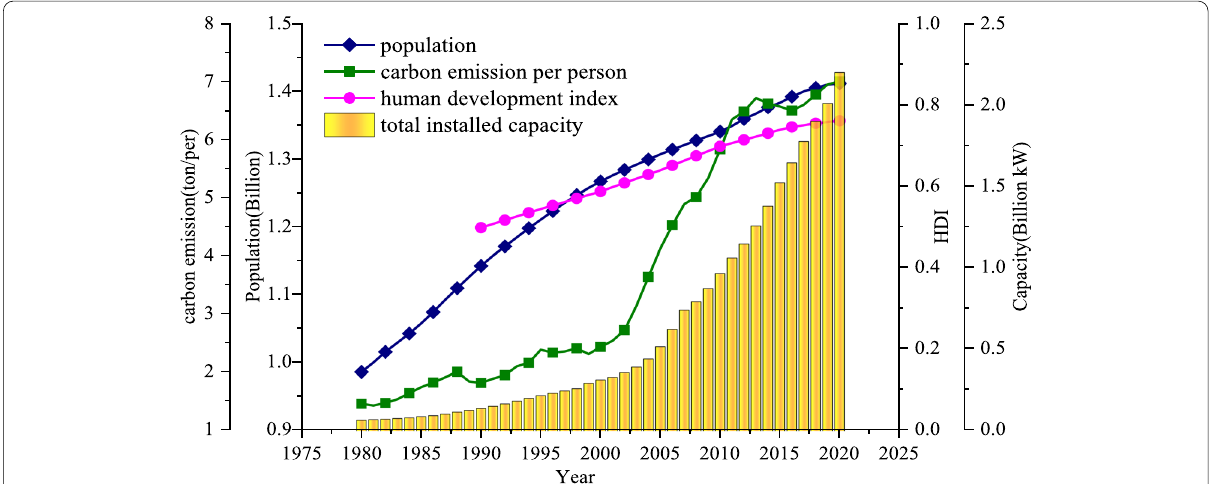
Fig. 1 Changes in China’s population, installed capacity, carbon emissions, and human development index over four